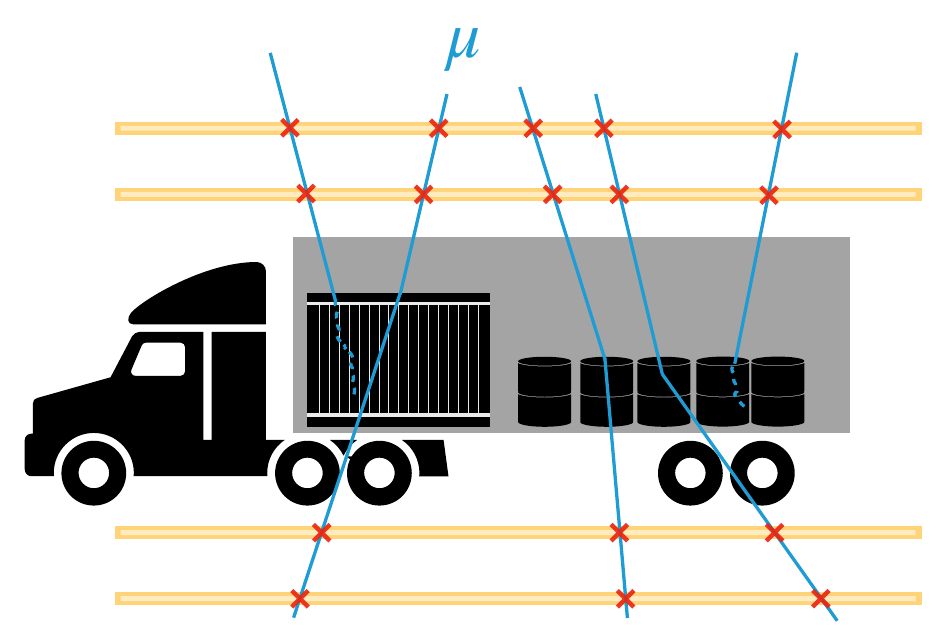
Figure 3. Concept of a muon screening portal for cargo